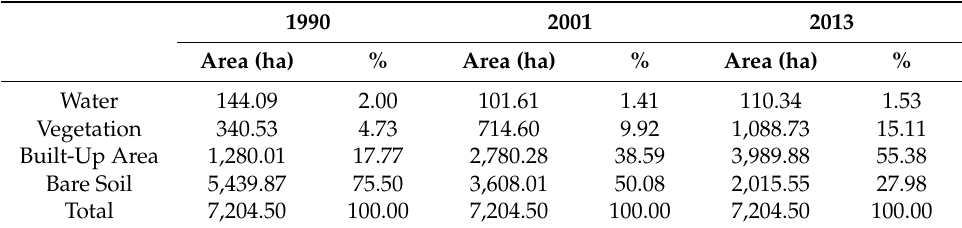
Figure 3. The classified images of the study area for 1990, 2001 and 2013. Table 5. Land cover in hectare and percentage during 1990, 2001 and 2013.